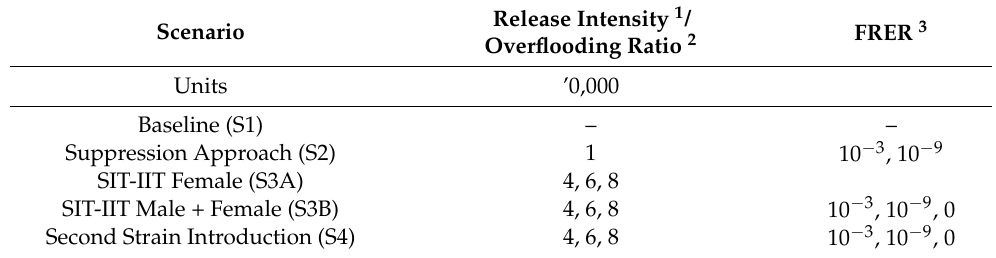
Table 2. Scenarios considered for modelling mosquito